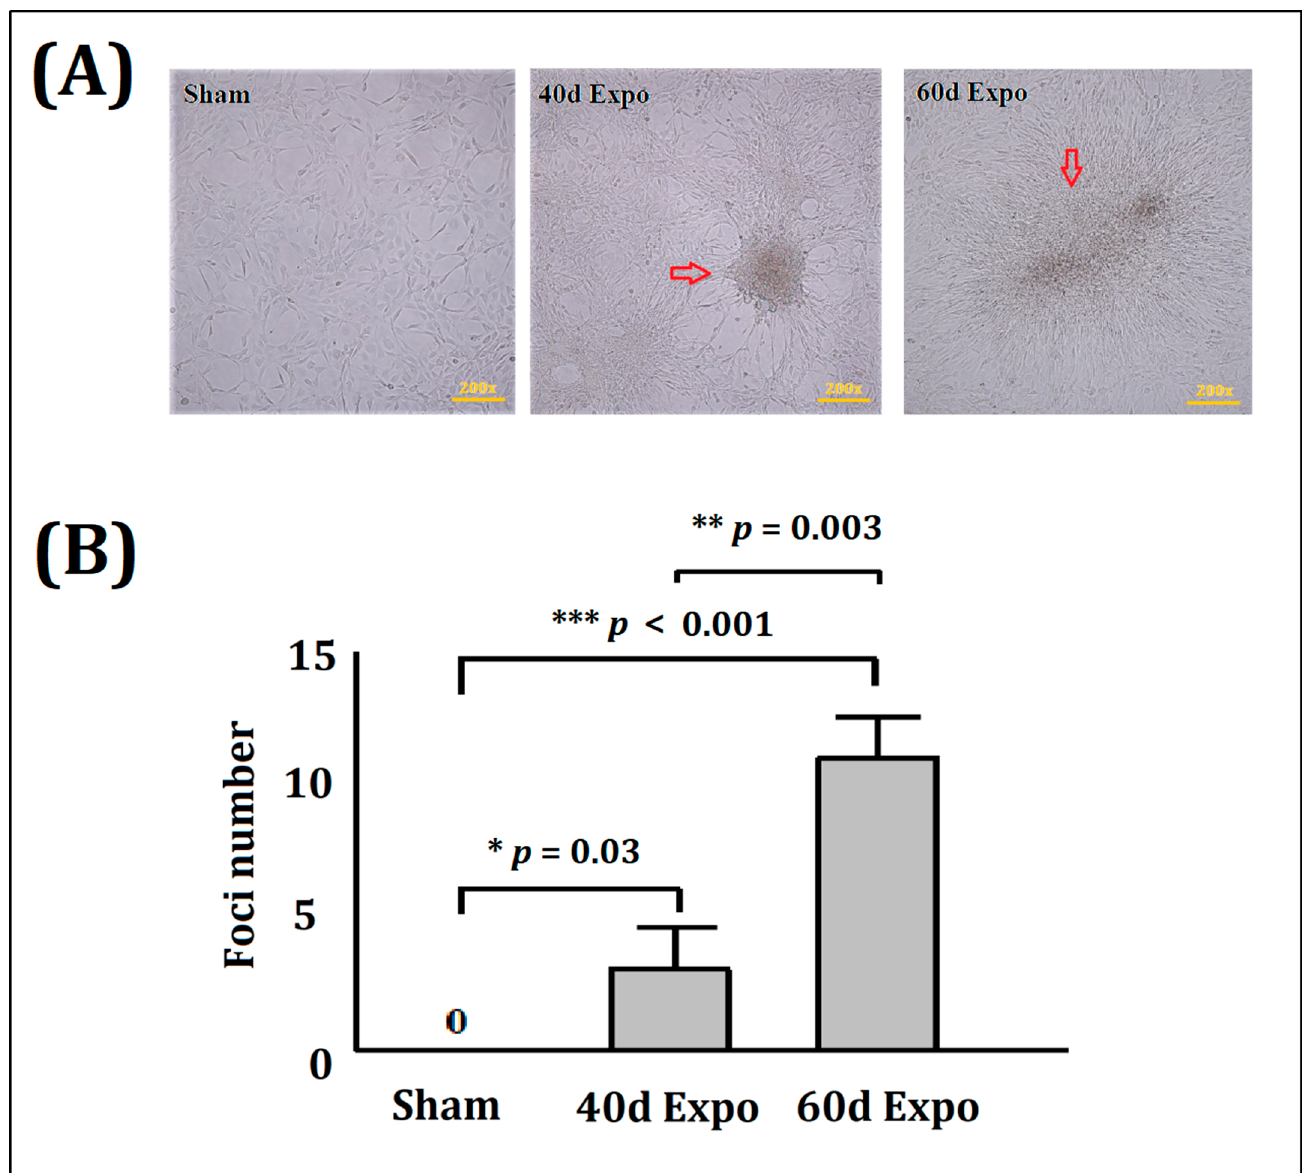
Figure 2. Malignant transformation of Balb/c-3T3 cells induced by 1800 MHz RF-EMR. No trans- formed foci were seen in sham Balb/c-3T3 cells. Visible foci (red arrows) could be observed in the 40-day and 60-day expo groups. ( A ) Foci were observed in the 40-day and 60-day expo Balb/c-3T3 cells; ( B ) histogram showing the mean foci numbers of the sham group and 40-day and 60-day expo groups. The statistical analysis was done using the t test. * p values < 0.05, ** p values < 0.01 and *** p values <